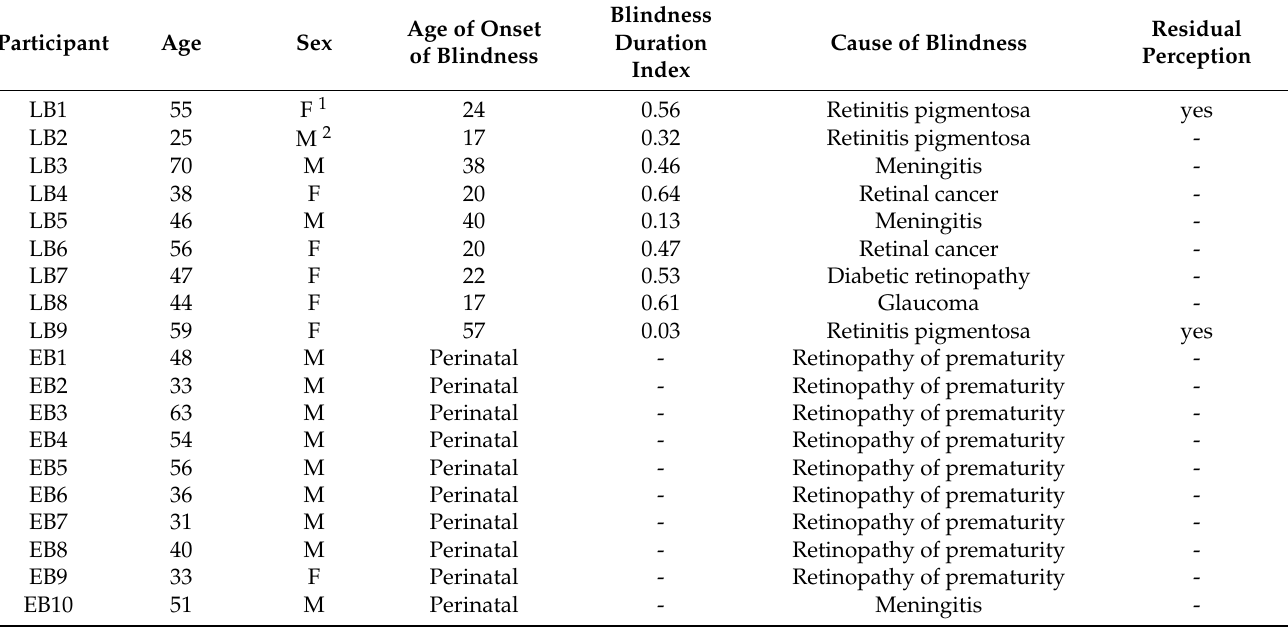
Table 1. Blind participants’ characteristics.